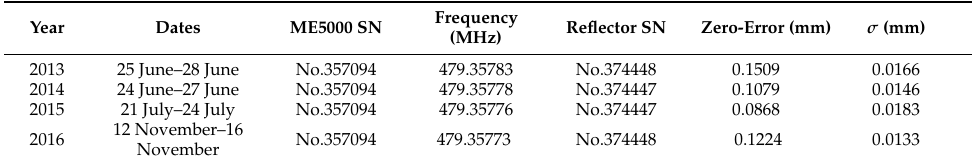
Table 3. Dates of the four campaigns and results of the calibration process for the Kern RMO5035 reflectors used. All values in